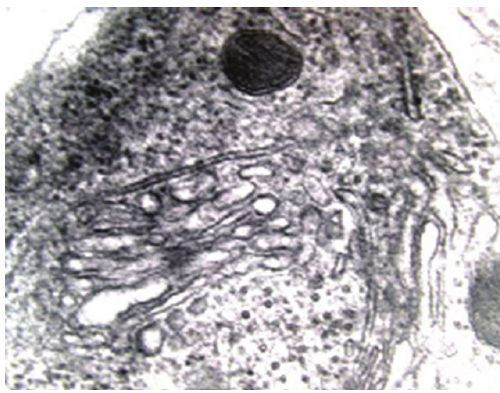
Figure 3: Small dense mitochondrion associated with fragmenta- tion of the cisternae of Golgi apparatus (meg.